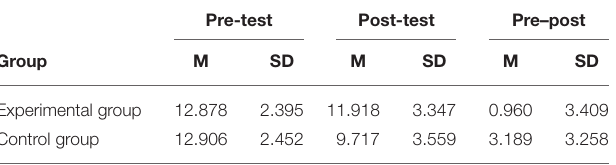
Pre-test Post-test